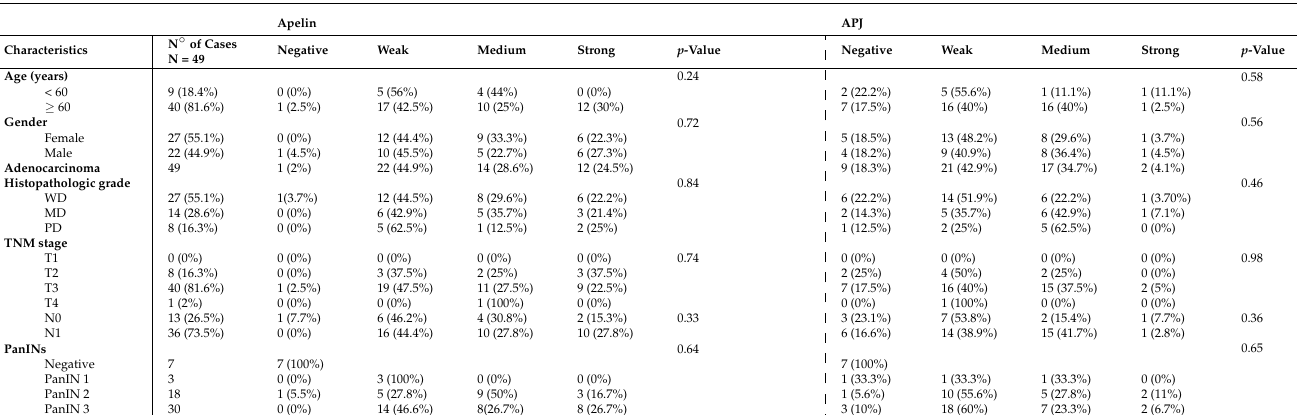
Table 1. Statistical analysis of apelin and APJ proteins expression and clinical characteristics of patients with pancreatic ductal adenocarcinoma ( n =